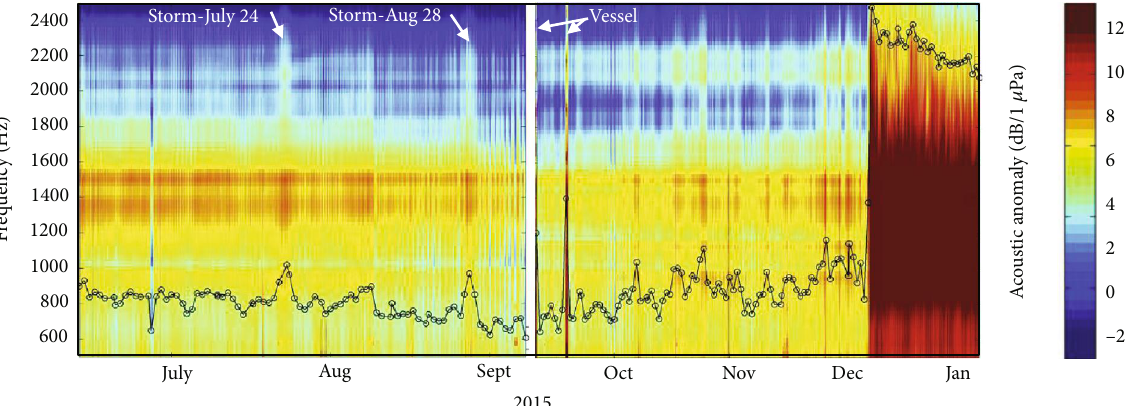
Figure 6: Long-term acoustic spectral observations for the North Sea 22/4b seep site and daily average (right axis). Fine striations (subdaily) are tidal emission variations. The acoustic spectrum relates to the bubble size spectrum. The September data gap re fl ects retrieval and deployment of a second recorder. From Wiggins et al.